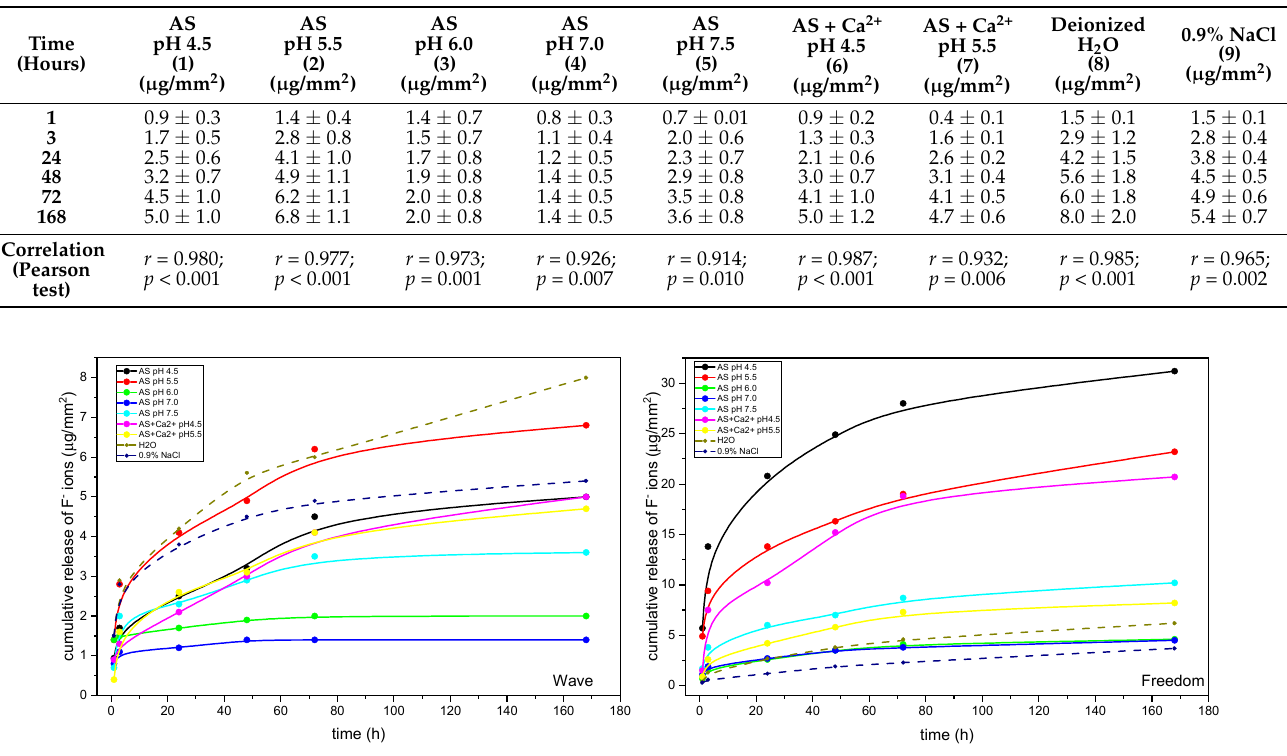
Table 2. Cumulated release of fluoride ions ( μ g/mm 2 ) from composite Wave (W) into nine environ- ments differing in composition of the solution and pH. Six samples were prepared for each solution. Descriptive data were presented as mean ± standard deviation (± SD). Data for correlation analysis were logarithmically transformed.